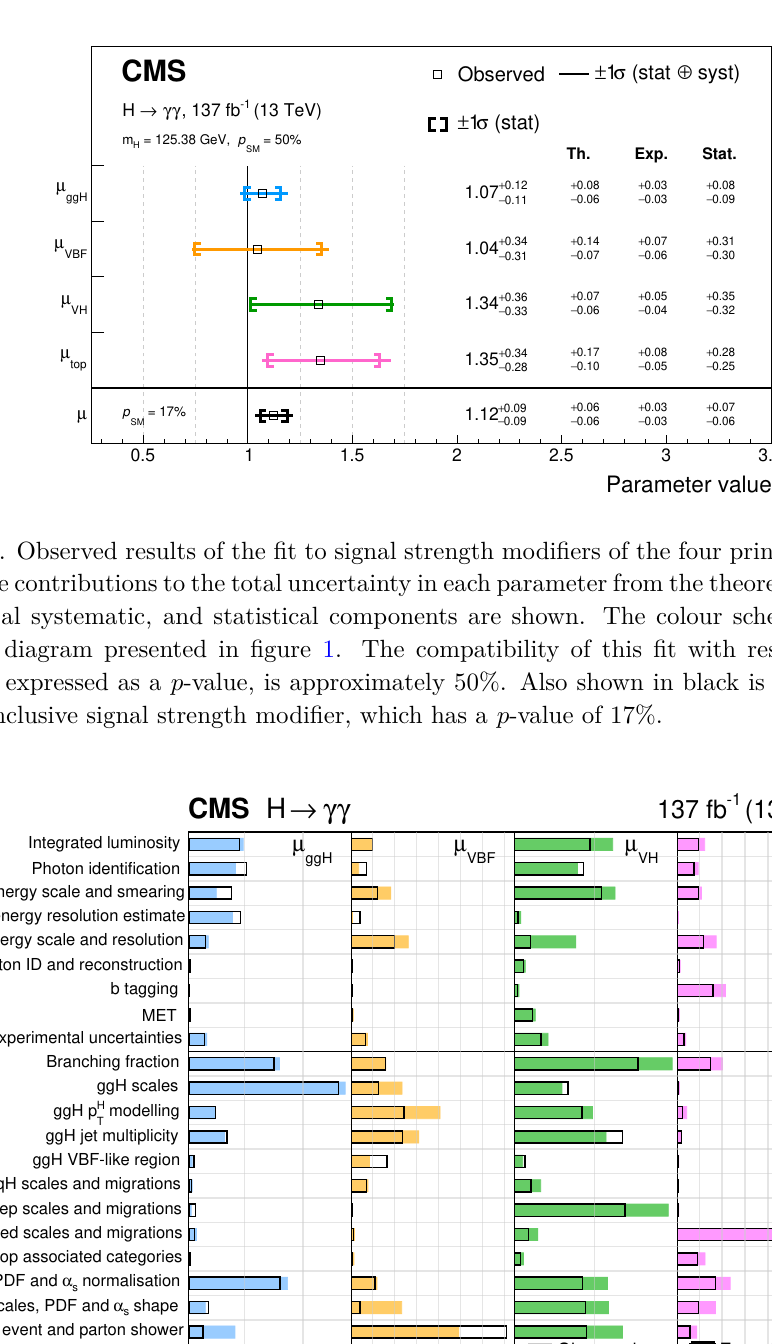
µ Uncertainty in i